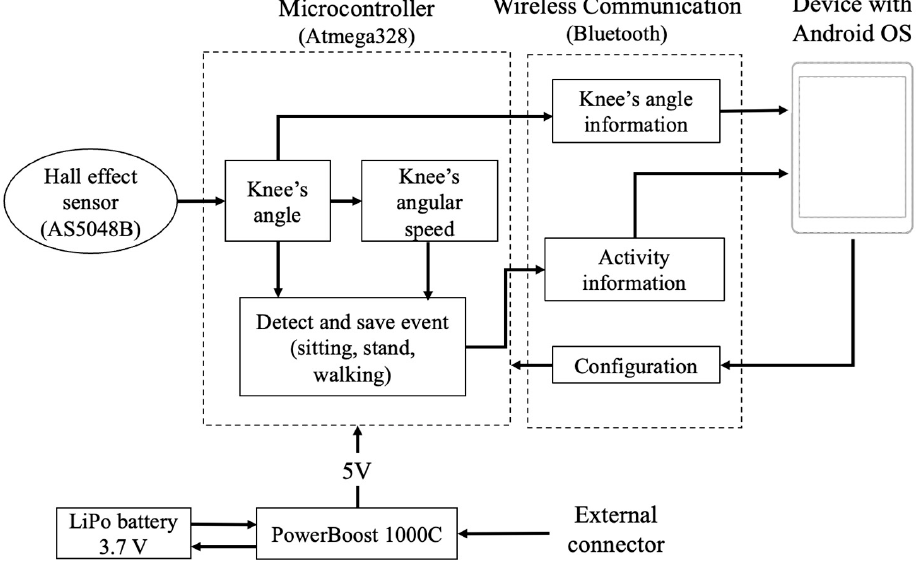
Figure 3. Interaction of the components of the wearable goniometer.